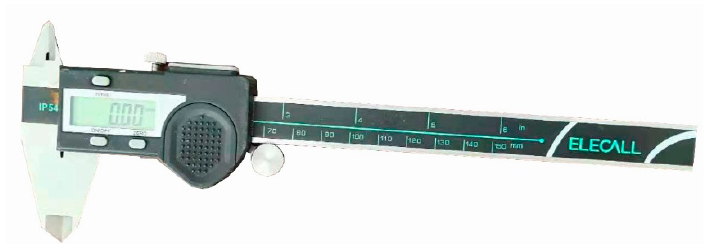
Figure 5. Vernier caliper. The resolution of the vernier caliper is 0.01 mm.